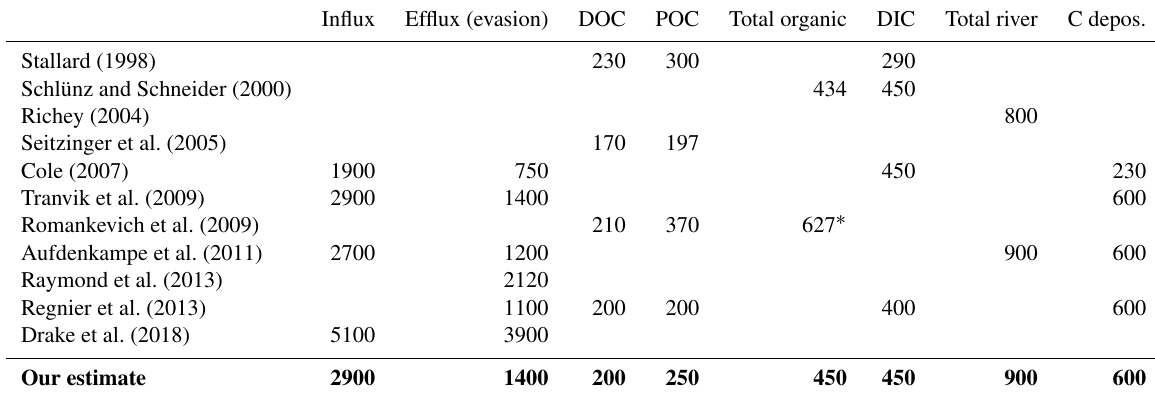
Table 2. Summary of prior estimates of the main components of carbon fluxes through inland